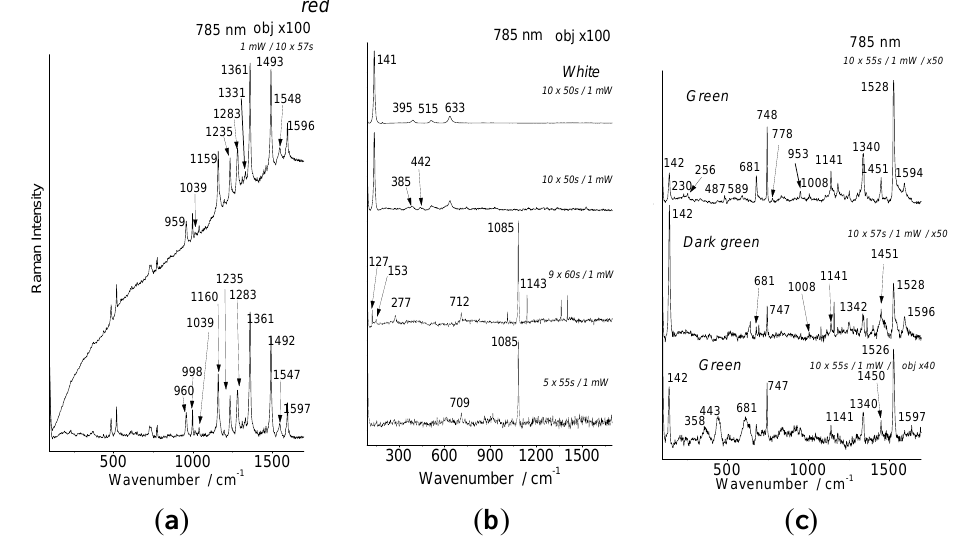
Figure 6. Representative Raman signatures recorded with 785 nm excitation, at different spots on the Ta Ty Lacquerware: ( a ) red, ( b ) white and ( c ) green. The baseline has been subtracted (except for a-top spectrum: the spectra before and after baseline subtraction are compared).